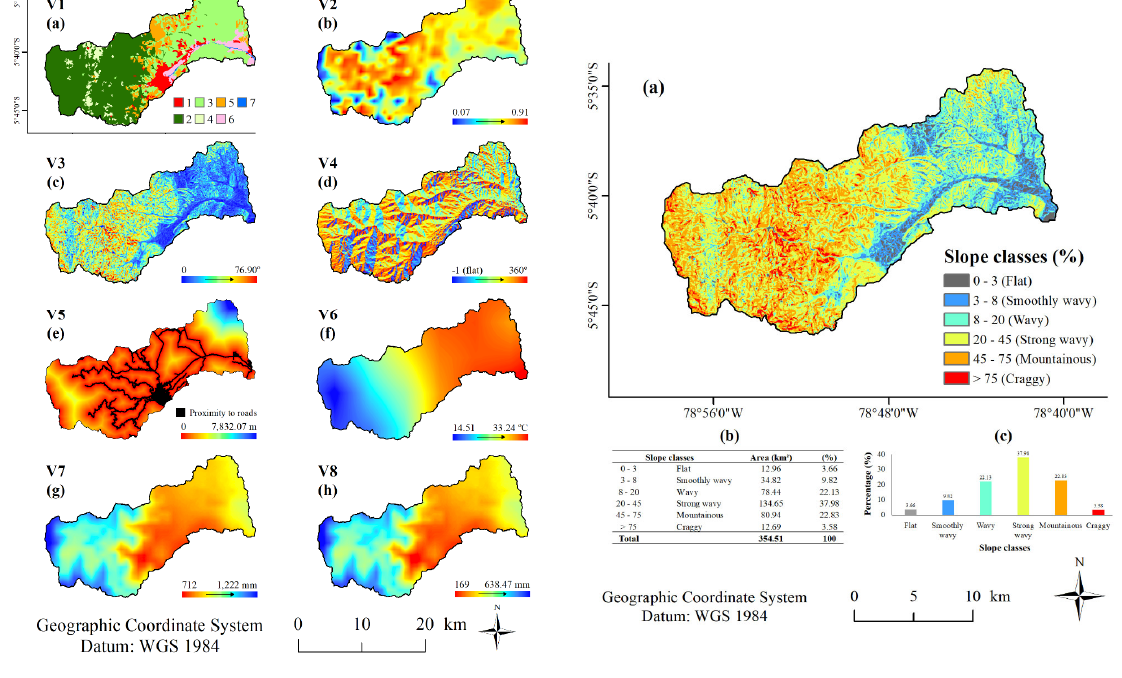
Fig. 4. Representative variables of Amojú river basin, Fig. 5. Slope of Amojú river basin, Cajamarca region,